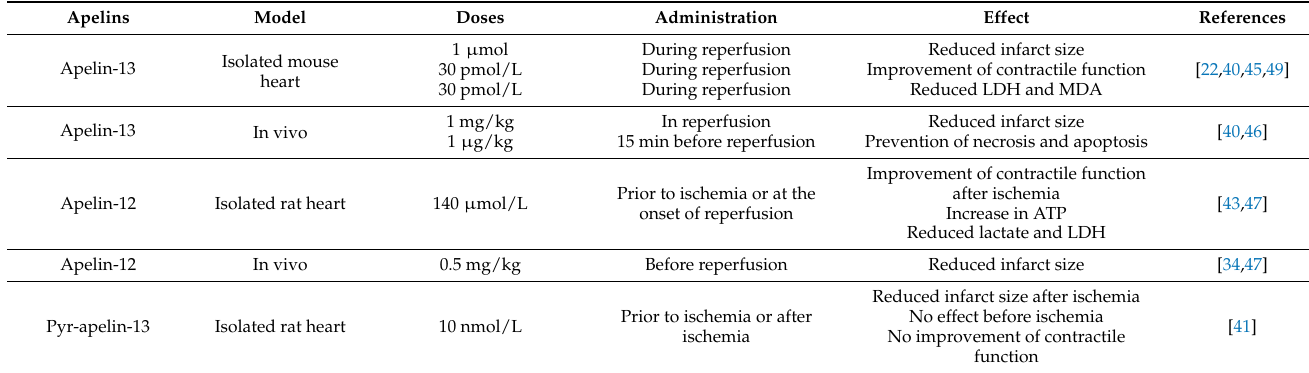
Table 2. The cardioprotective effect of